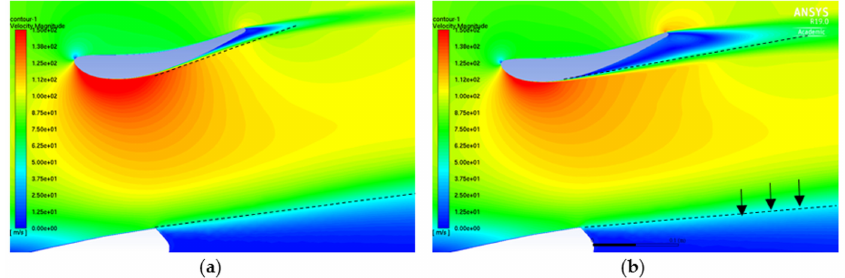
Figure 15. Comparison of total pressure distributions at a vehicle driving speed of 300 km / h; ( a ) Without flow discharge; ( b ) Discharge at 0.50C with Vb / U = 0.4.